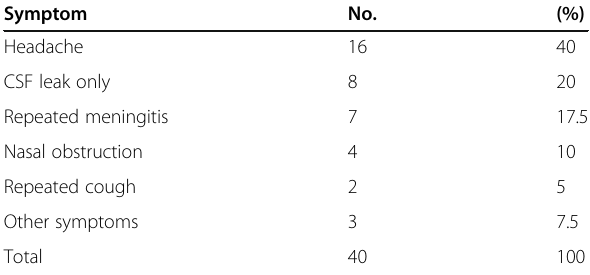
Table 2 Distribution of symptoms associated with CSF leak